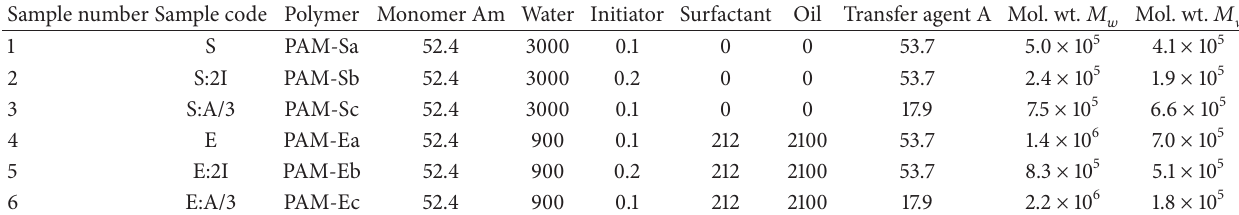
Table 1: Recipes of solution (S) and emulsion (E) polymerization experiment of acrylamide at 50 ∘ C. All quantities are given in grams. The weight average molecular weight 𝑀 𝑤 was calculated from the GPC and the viscosity average molecular weight 𝑀 V was calculated from viscosity measurement and given in g ⋅ mol − 1